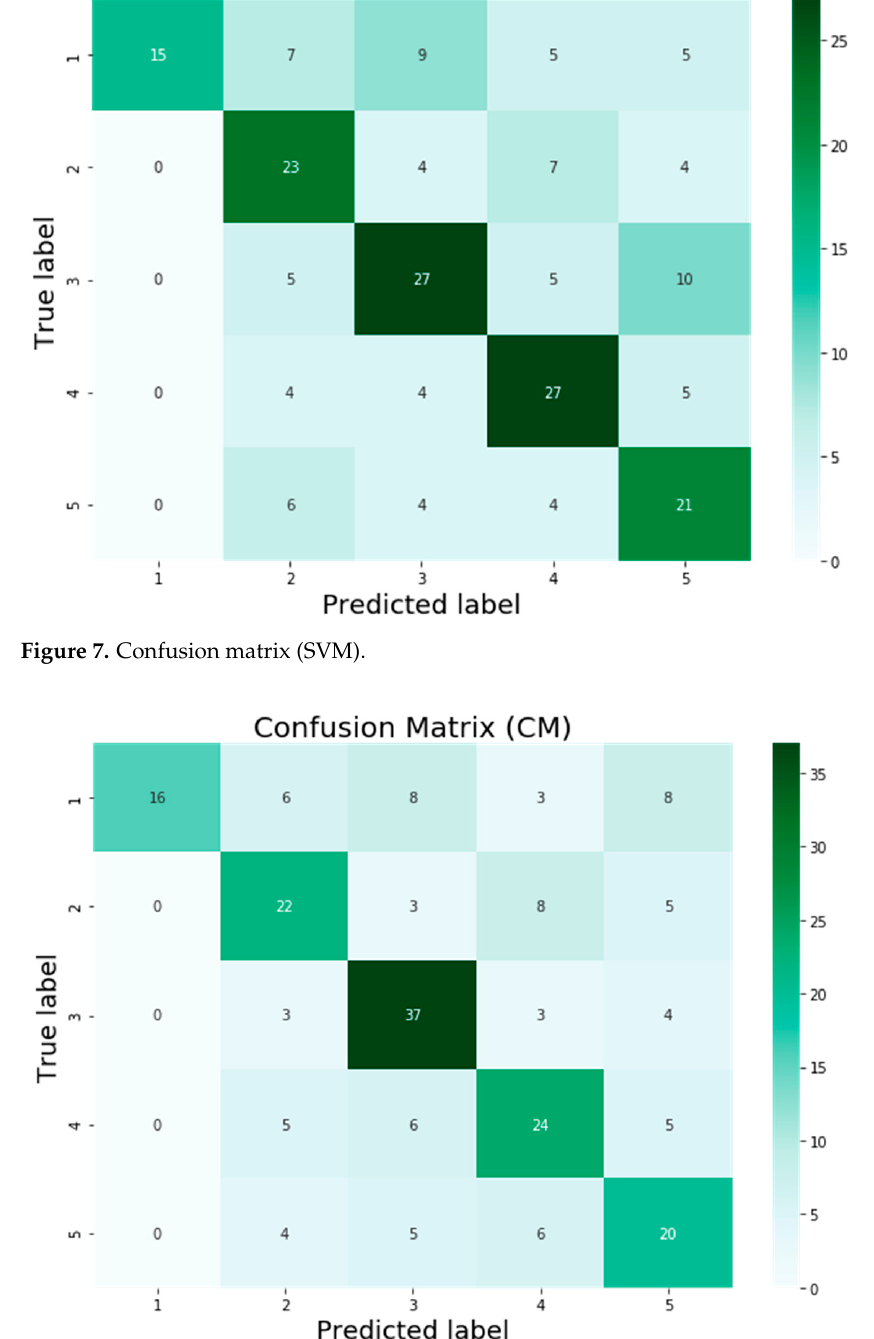
Figure 9 . Confusion matrix (InceptionV3). In addition, we evaluated the predictive performance of the SVM, VGG16, Incep- tionV3, and AQE-Net models with the help of three statistical error metrics known as mean squared error (MSE), mean absolute error (MAE), and mean absolute percentage error (MAPE). Table 4 shows the MSE, MAE, and MAPE values. When applied to the testing dataset, the SVM model achieved values of 1.915 MSE, 0.830 MAE, and 0.473 MAPE, respectively. The MSE was found to be 1.910, the MAE was 0.796, and the MAPE was found to be 0.465 using the VGG16 model. When compared to the SVM model, the VGG16 model produced fewer errors than the SMV model. Following the application of the VGG16 model, we next applied the InceptionV3 model, and the results of MSE, MAE, and MAPE were 1.373, 0.626, 0.326, respectively, which also reflects fewer errors than were produced by the earlier models, SVM and VGG16. In overall, the AQE-Net model that we proposed had a lower error rate than the other models that were employed in this